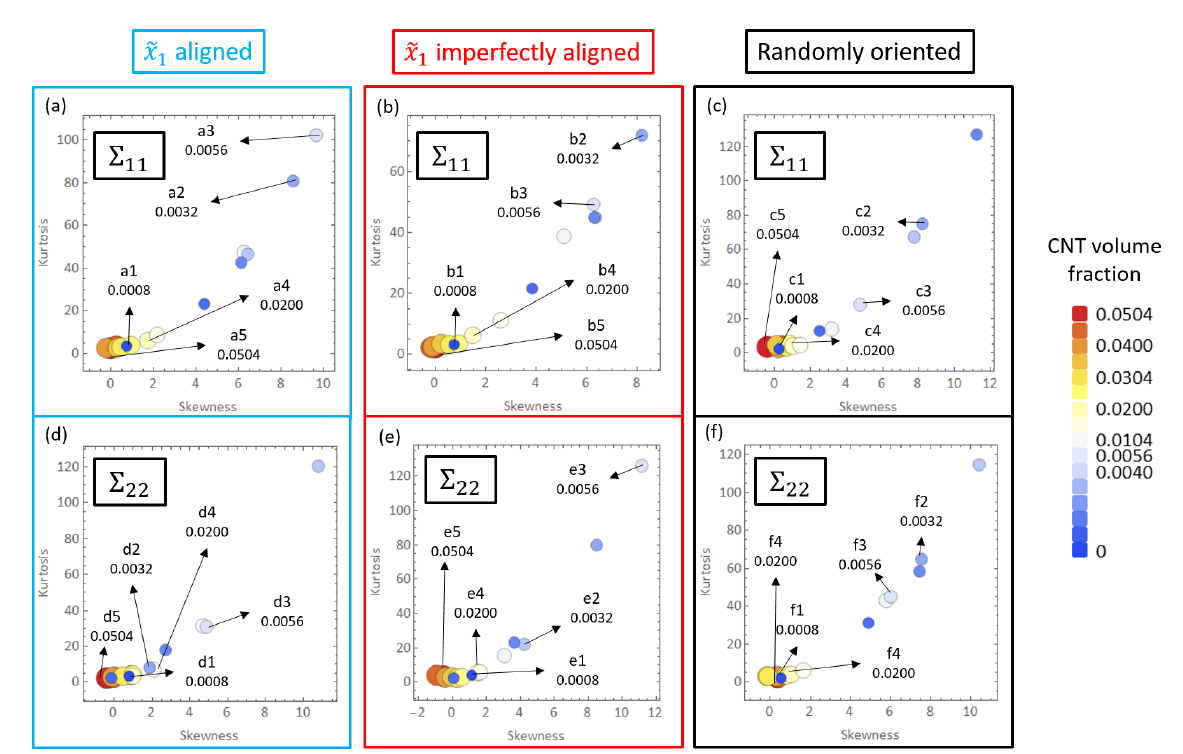
Figure 16. Skewness-Kurtosis plots for Σ 11 for the ( a ) straight ˜ x 1 aligned case, ( b ) straight ˜ x 1 imper- fectly aligned case and ( c ) straight randomly oriented case and for Σ 22 for the ( d ) straight ˜ x 1 aligned case, ( e ) straight ˜ x 1 imperfectly aligned case and ( f ) straight randomly